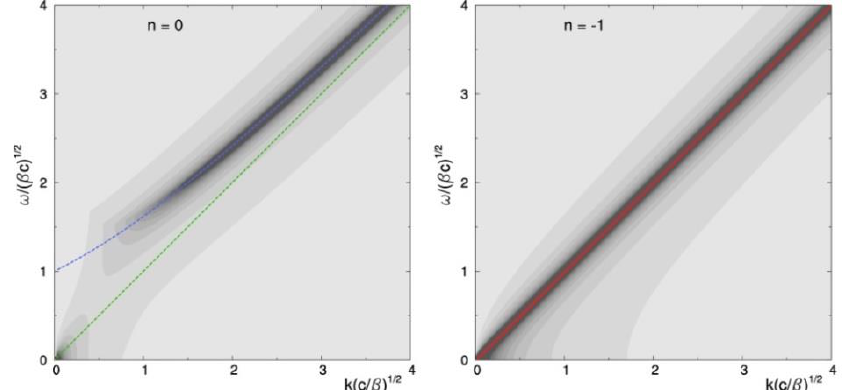
Figure A4. Similar to Figure A3, except for the eastward travelling modes with n = 0 ( left ) and −1 ( right ). The red line indicates the sole resonance condition.